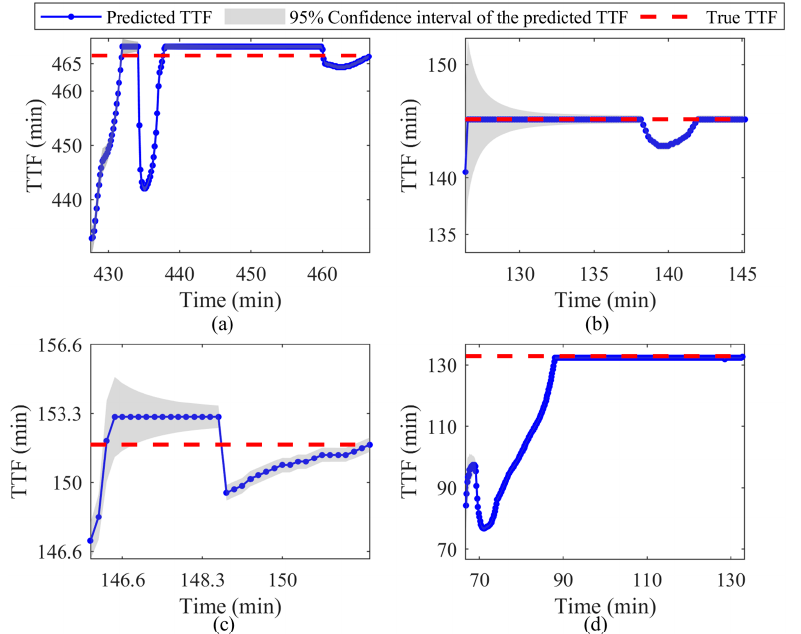
Figure 13. TTF prognostic results and the 95% confidence interval of ( a ) bearing 1_1, ( b ) bearing 1_2, ( c ) bearing 2_1, and ( d ) bearing 2_2.